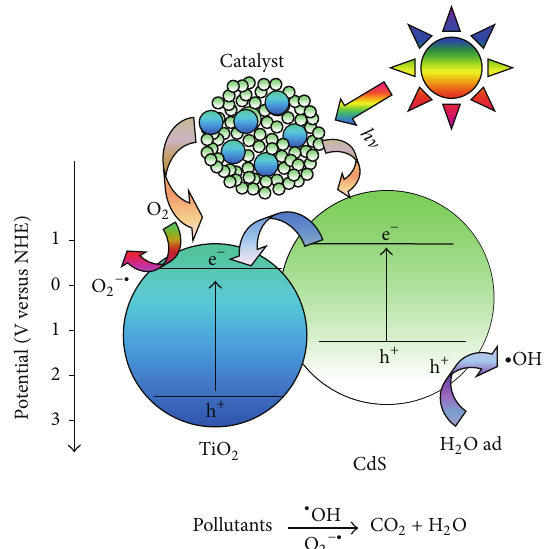
Scheme 2: The possible photocatalytic mechanism of TiO 2 /CdS mesoporous